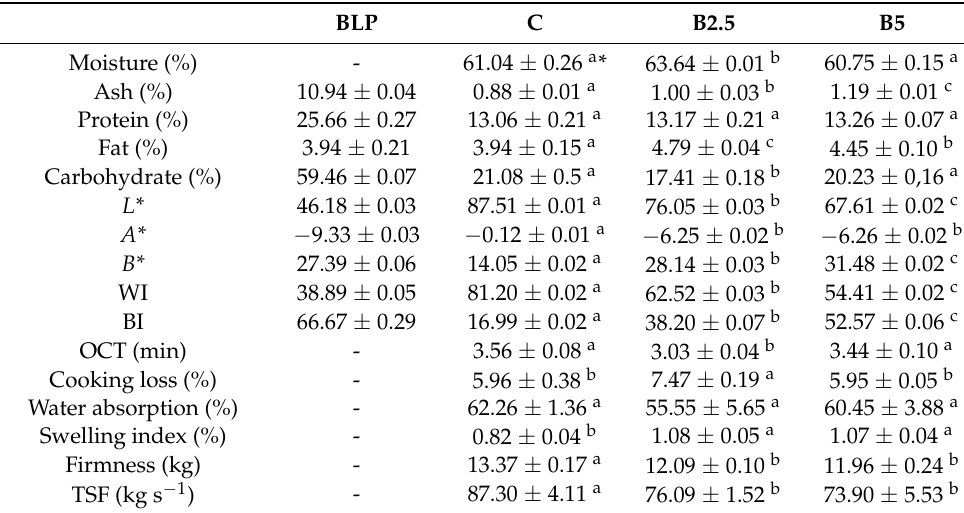
Table 2. Proximate composition, colour characteristics, cooking and texture properties of BLP and experimental pasta expressed as mean ± standard deviation